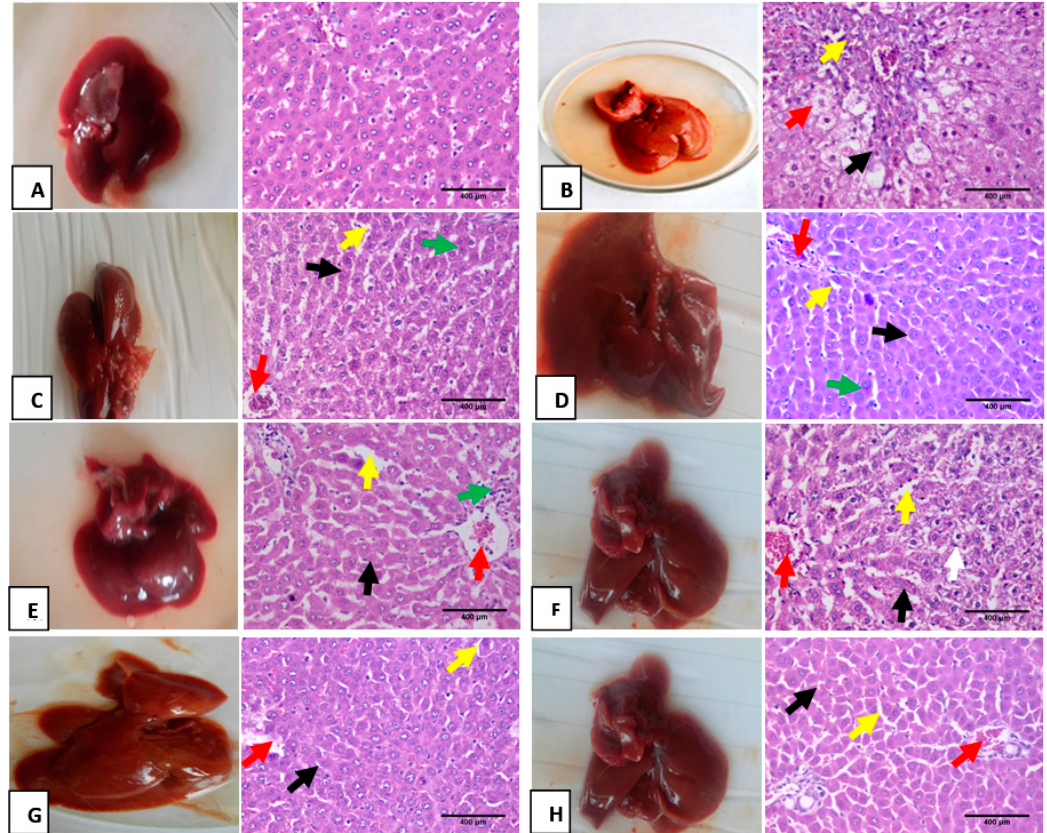
Figure 5. Photomicrograph of sections of hematoxylin and eosin (H and E, x400) for liver tissues of different treated groups. ( A ) represents the sections from the normal control group with typical structure and morphology of the liver tissue; ( B ) TTA-intoxicated group showed severe abnormalities, partial distortion of lobular hepatic architecture (black arrow), with moderate hydropic degeneration of hepatocyte (red arrow) and thick fibrous tissue in portal tract (blue arrow); ( C , D ) liver sections treated with MS and nano MS showed hepatic tissue with almost normal intact hepatic lobular architecture and structure, hepatocytes arranged in thin plates (black arrow) and sinusoids (yellow arrow), central vein (red arrow), binucleated nuclei (green arrow); ( E , F ) liver sections treated orally with PMS nano PMS as a prophylactic group. They demonstrated tangible improvement as hepatic tissue was almost in normal intact hepatic lobular architecture and structure; hepatocytes arranged in thin plates (black arrow) with mild interlobular inflammatory infiltration (green arrow) and sinusoids (yellow arrow), congested central vein (red arrow), hepatocytes with moderate hydropic degeneration (white arrow); ( G , H ) liver sections treated with MS and MS nano groups showed improvement in hepatic tissues as it appeared in intact lobular hepatic architecture, hepatocyte with thin plates (black arrow), congested central vein (red arrow) and congested sinusoids (yellow arrow) (( H , E ), x400).